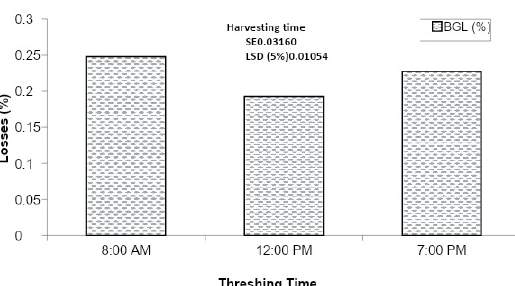
Fig. 1: Effect of Wheat Harvesting Time and Method on Harvest and Hauling Losses (%)